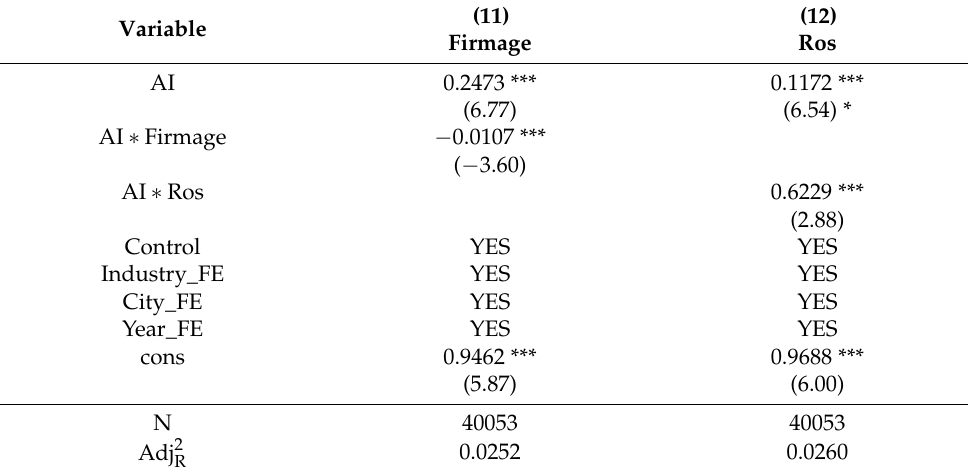
Table 6. Heterogeneity